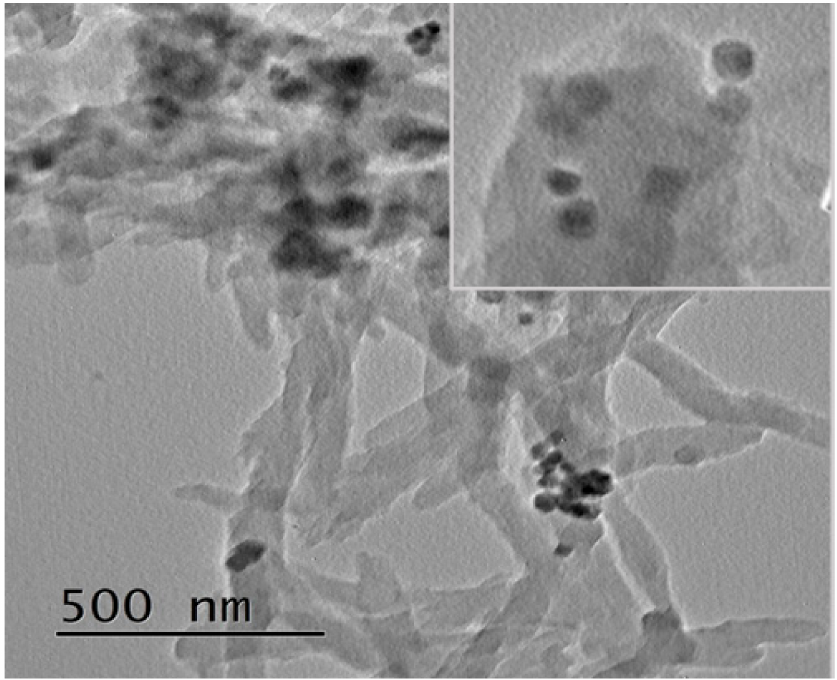
Figure 3. TEM image of Ag / Co 3 O 4 @PANI ternary nanocomposite and inset image focused on the Co 3 O 4 and Ag nanoparticles embedded in the PANI matrix.